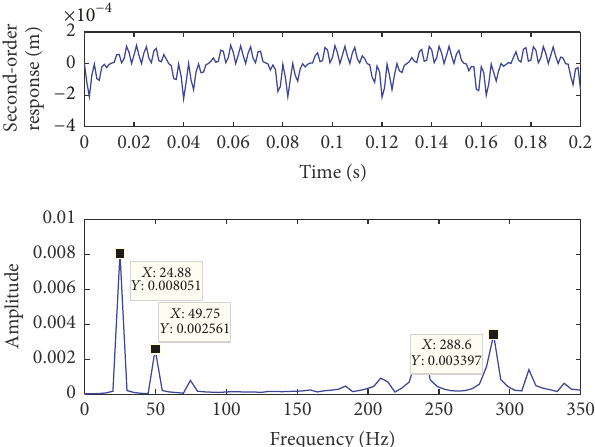
Figure 5: The second-order response and amplitude-frequency characteristics of the first flexible intermediate link.